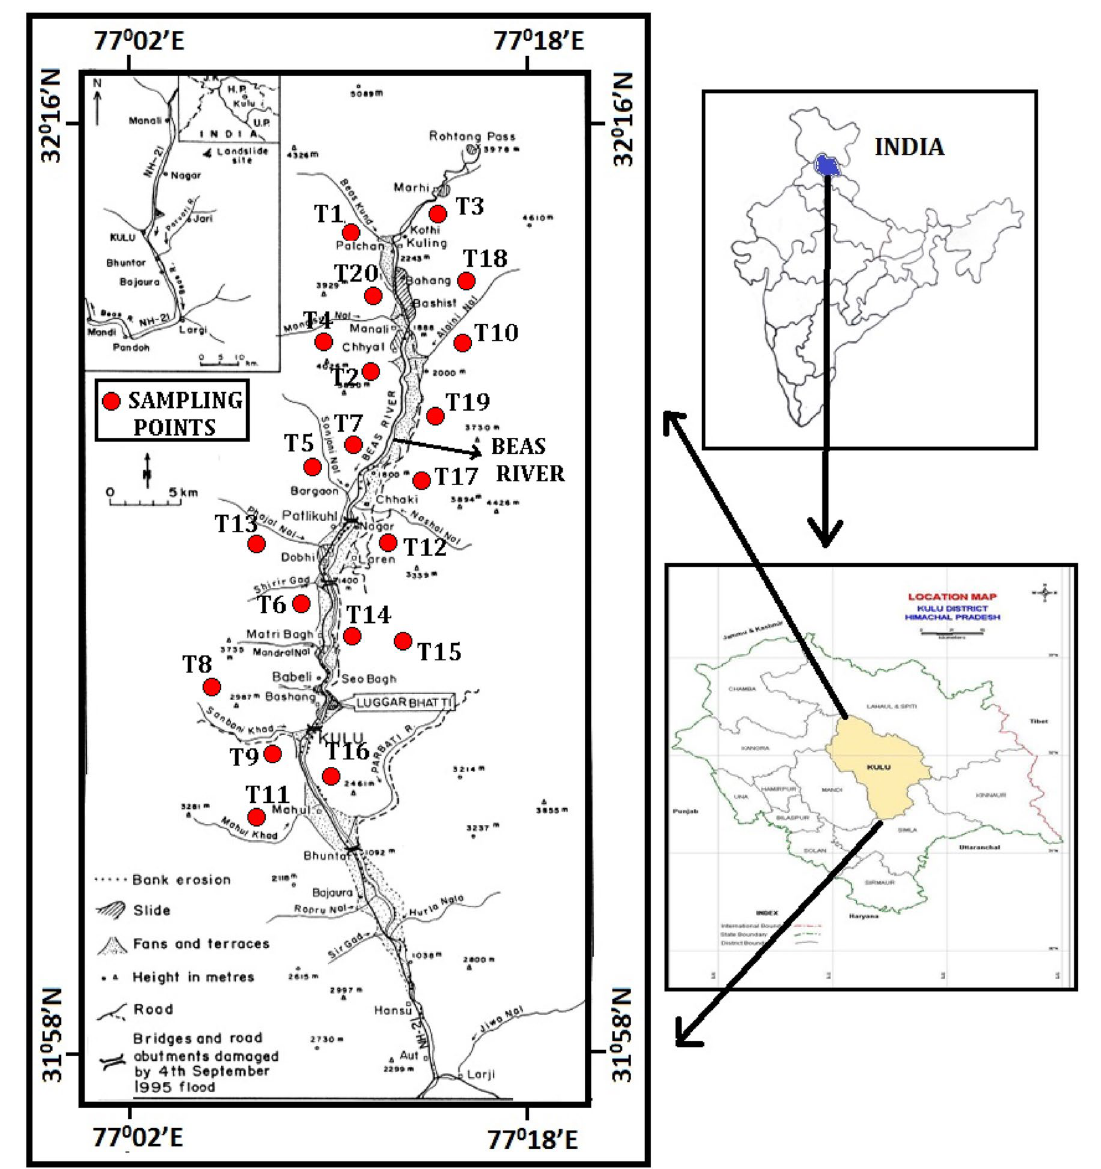
Fig. 1 Location map of the study area and sampling